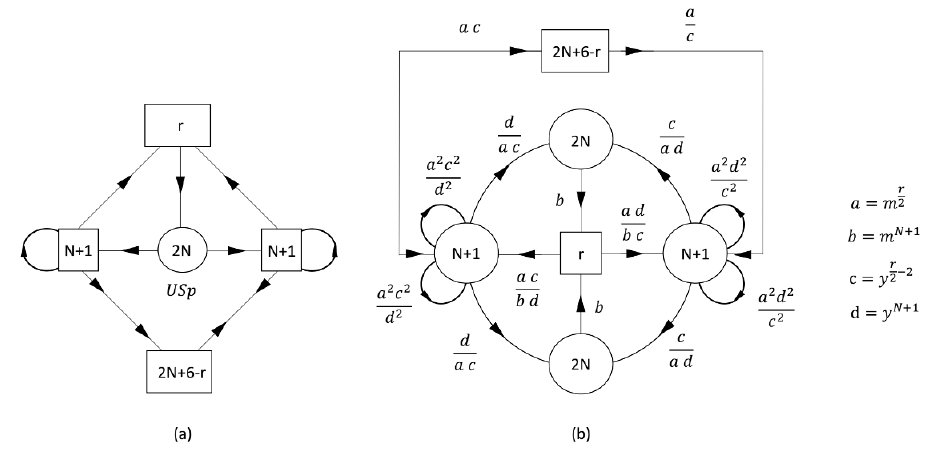
U(1) (cid:2) (cid:2) 1 . 2 (cid:0)